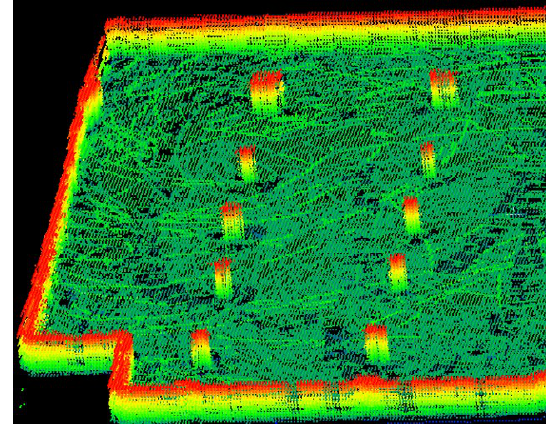
Figure 15. The static point cloud